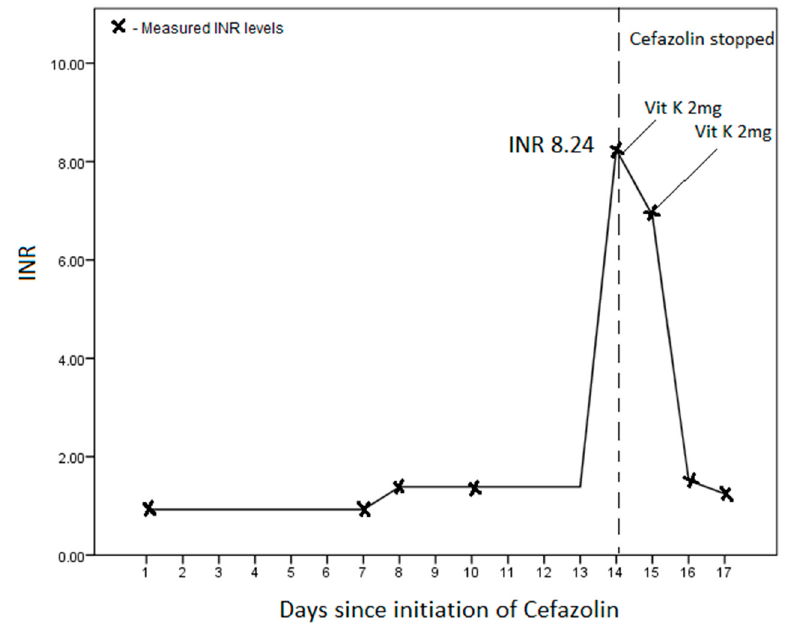
Figure 1. International normalised ratio (INR) trend on initiation and subsequent cessation of IV IV cefazolin.